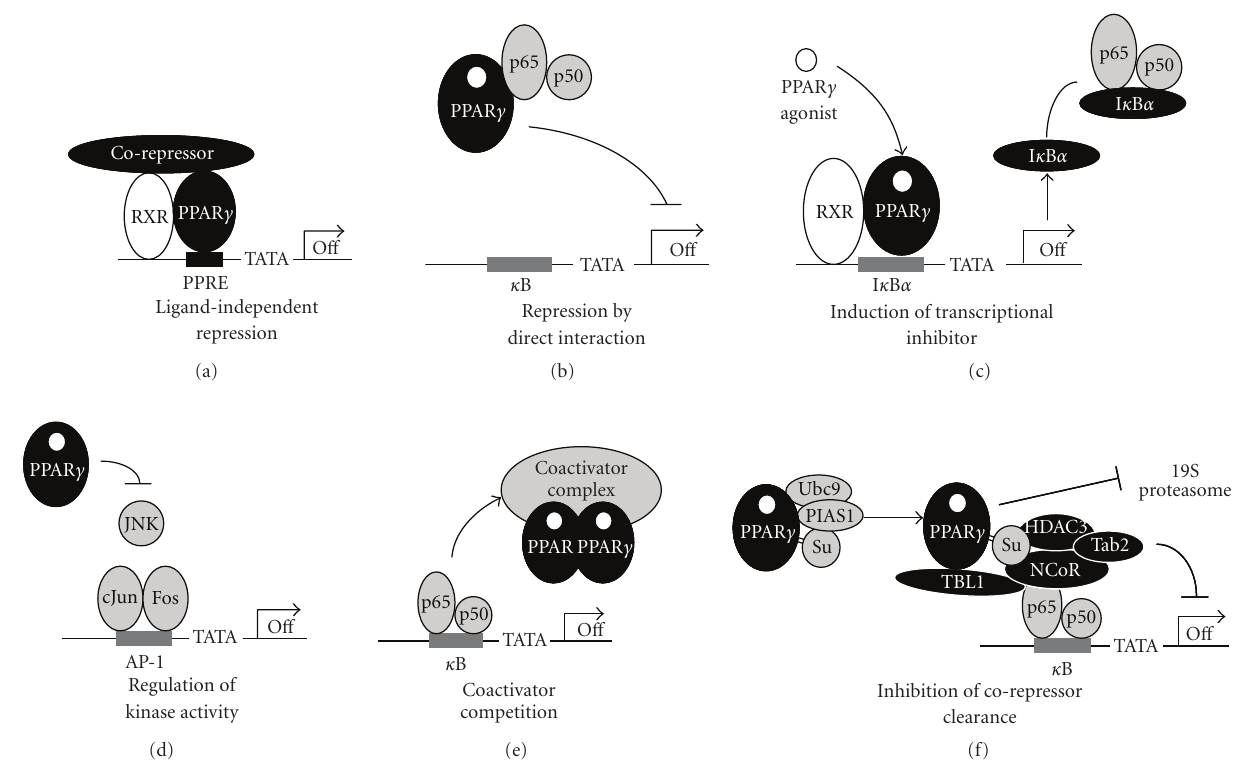
Figure 2: Mechanisms of transrepression by PPAR γ . (a) Ligand-independent repression: preferential recruitment of corepressors in the absence of agonists. (b) Direct binding and sequestration of transcription factors on example of NF κ B. (c) Activation of genes encoding inhibitors of transcription factor (e.g., NF κ B inhibitor, I κ B α ). (d) Direct binding and inactivation of kinases, which activate transcription factors (e.g., the blockade of JNK activation of cJun). (e) Competitive binding of the coactivator complex. (f) The blockade of corepressor clearance: sumoylated PPAR γ stabilizes corepressor complexes (NCoR, Tab2, and TBL1) on the promoter and facilitates the recruitment of HDAC3. In the absence of sumoylation, NCoR, Tab2, and TBL1 are subject to ubiquitination and proteasomal